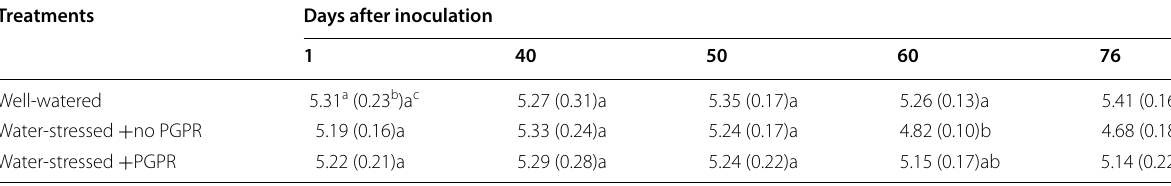
a Values are means of three repeating groups (twelve seedlings for each repeat group) b Numbers are standard deviations c Different letters indicate significant differences among treatments at P < 0.05 by LSD